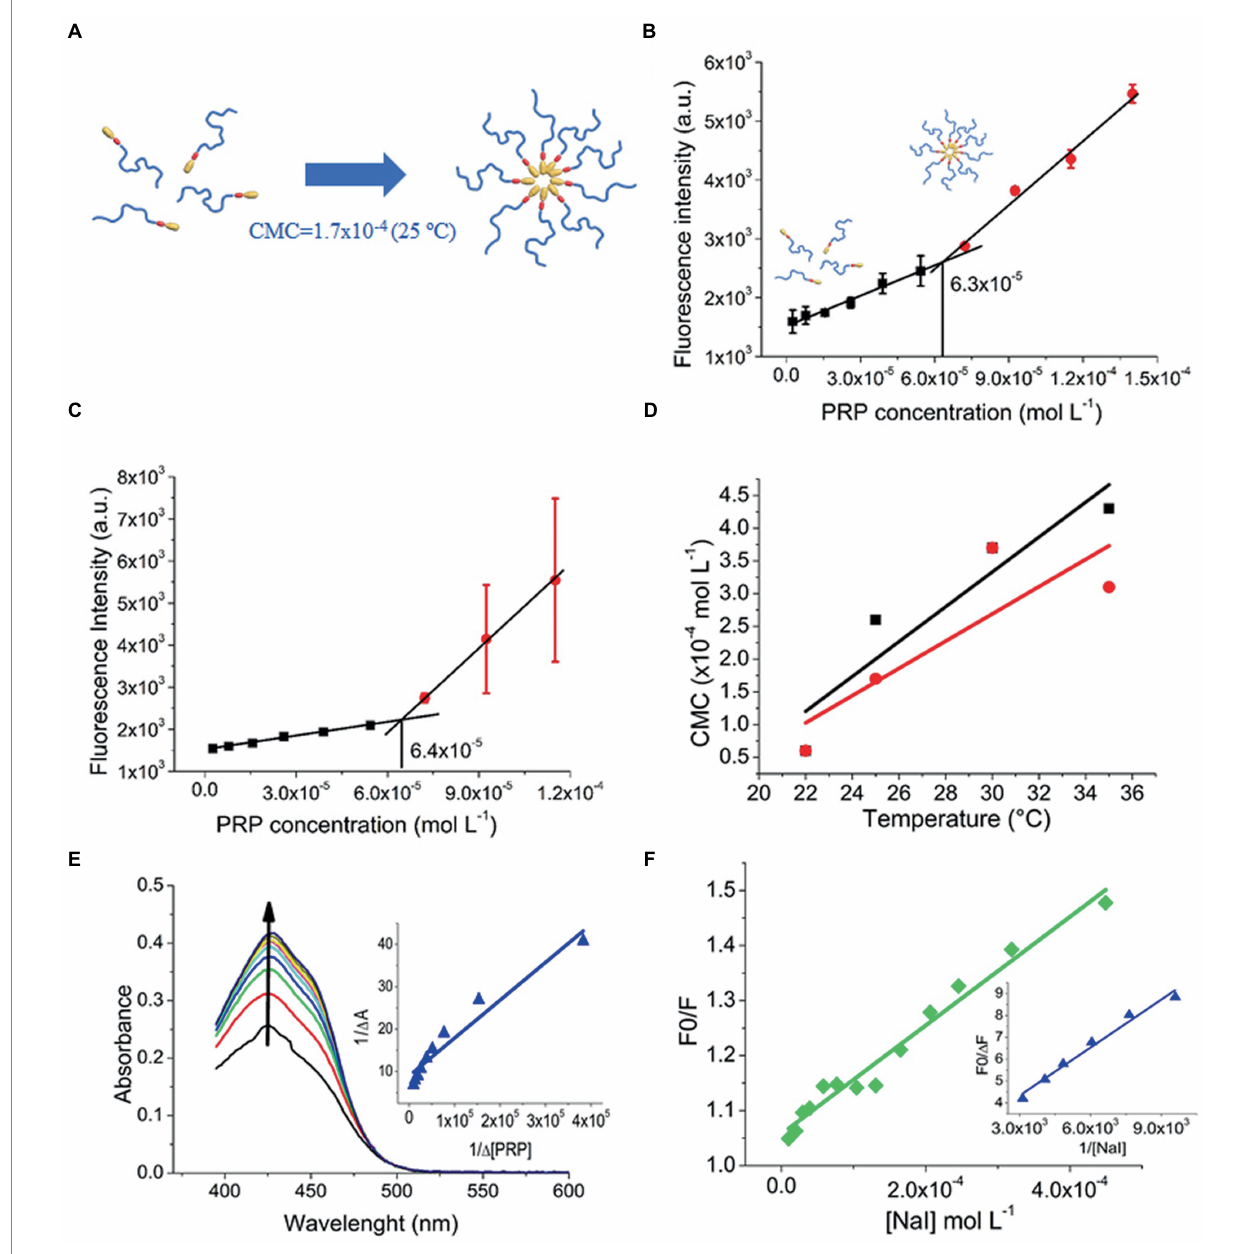
FIGURE 3 (A) Micelle formation at 25 ° C. (B) CMC of PRP at 22 ° C in the presence of pyrene. (C) CMC of PRP at 22 ° C in the presence of CUR. (D) Linear fitting of CMC versus temperature: PRP (black squares); CUR-loaded PRP (red circles). (E) Ks of PRP to CUR, the arrow indicates an increase in absorption spectra. (F) Fluorescence quenching of free CUR (green diamonds) and CUR-loaded PRP micelles (blue